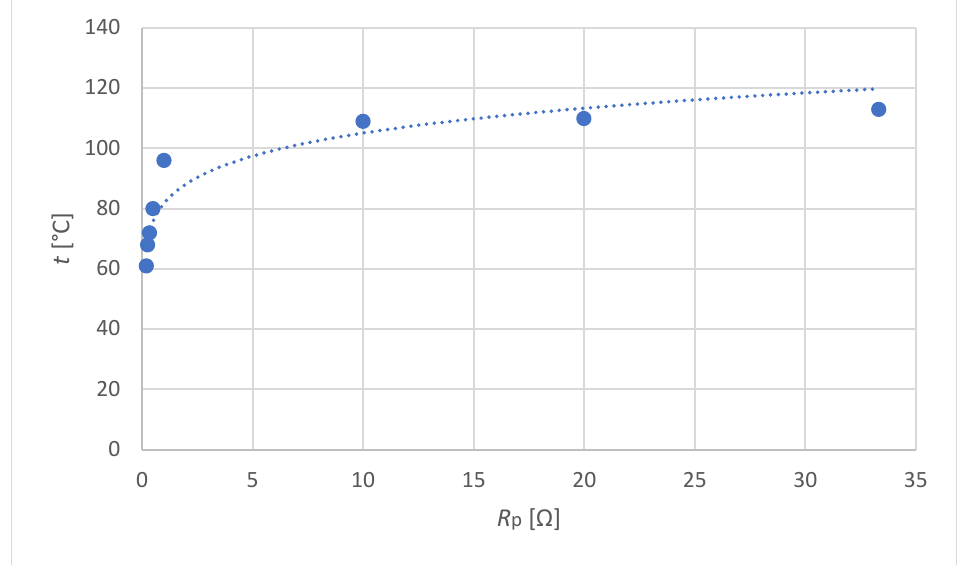
Figure 11. Temperature distribution around DC connector with current flow ( I = 9 A) — case 8 in Table 1. Max temperature: 113 °C.